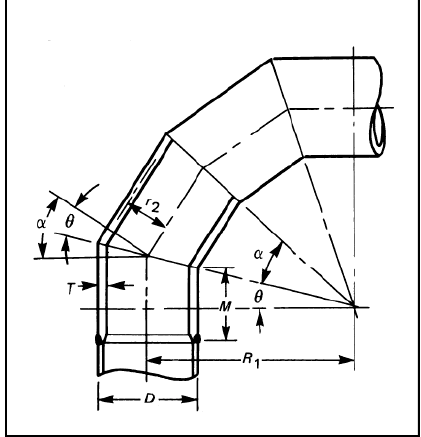
Figure 12. Mitered bend nomenclature as per ASME B31.3.